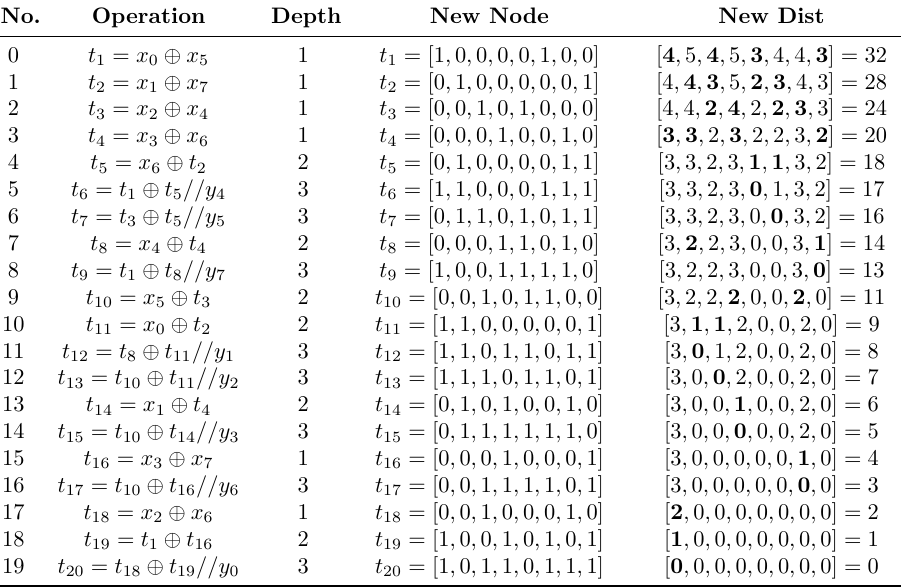
Table 5: The implementation of M C using LSL algorithm